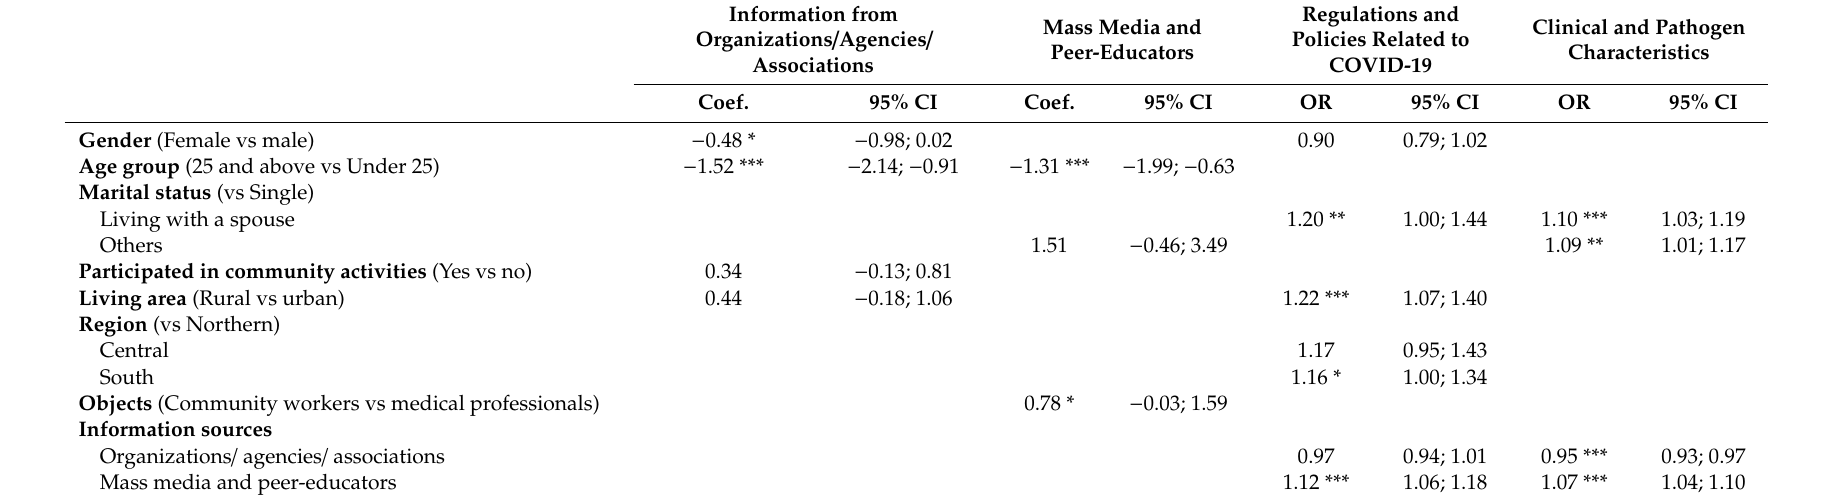
Table 5. Factors associated with COVID-19 information sources and